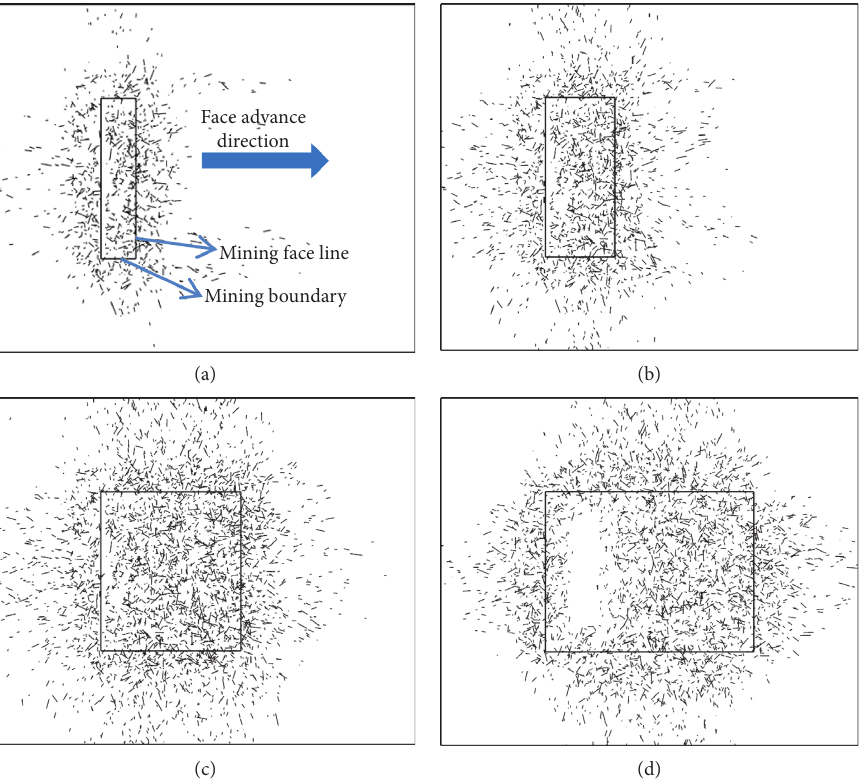
Figure 12: Evolution of the fracture network in the typical lower strata (pebbly sandstone) with mining advance based on the horizontal section planes: (a) 50m; (b) 100m; (c) 200m; (d) 300